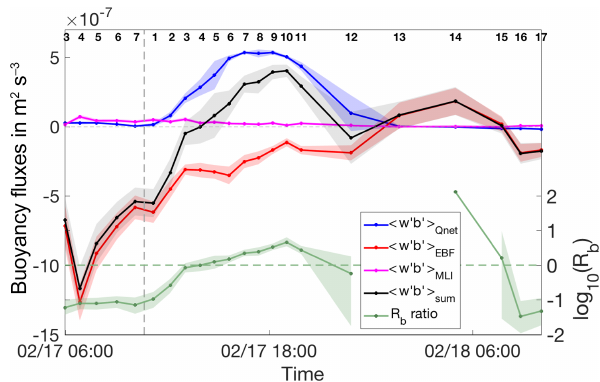
Figure 9. Vertical buoyancy fluxes associated with surface heating (blue), Ekman transport (red), and mixed-layer instabilities (ma- genta). The shaded areas around the Ekman buoyancy flux (EBF) and the buoyancy flux associated with mixed-layer instabilities (MLI) account for uncertainties in the surface salinity gradient (see text for more details). The shaded uncertainty range for vertical buoyancy fluxes due to surface heating is given as 1 standard de- viation obtained from sectional averaging. The sum of the three processes is given by the black line. The uncertainty is given as the maximum error resulting from the three processes. The R b ra- tio (green) and its uncertainty are treated similarly. For cross-frontal transect 13 and 14 no R b value or error can be stated due to the van- ishing denominator in the definition of R b . log 10 (R b ) > 0 points towards a net restratification, while log 10 (R b ) < 0 indicates a desta- bilization of the water column. For calculation details of all quanti- ties see text. Time is given in UTC. The small black numbers on top indicate the respective zonal or cross-frontal transect number.